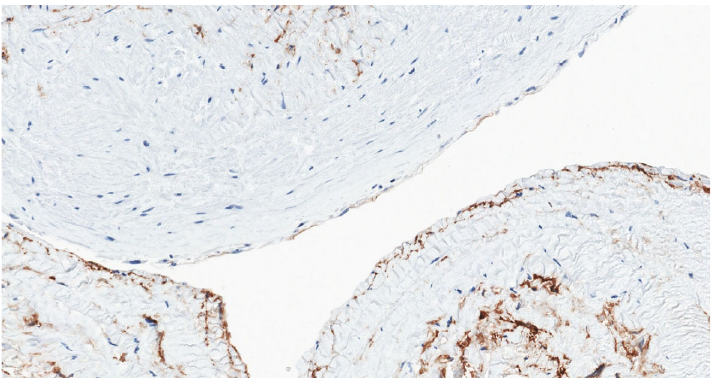
Figure 5: A negative immunohistochemical reaction of CD34 (background-positive internal control-positive staining of small vascular epithelium) precludes the diagnosis of vascular cysts.